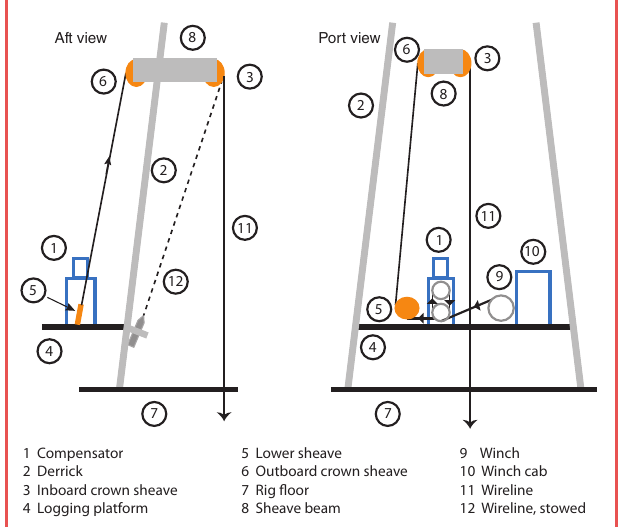
Figure 2. Aft- and port-facing cross-section views of the IODP AHC and logging system. From Liu et al., 2012.